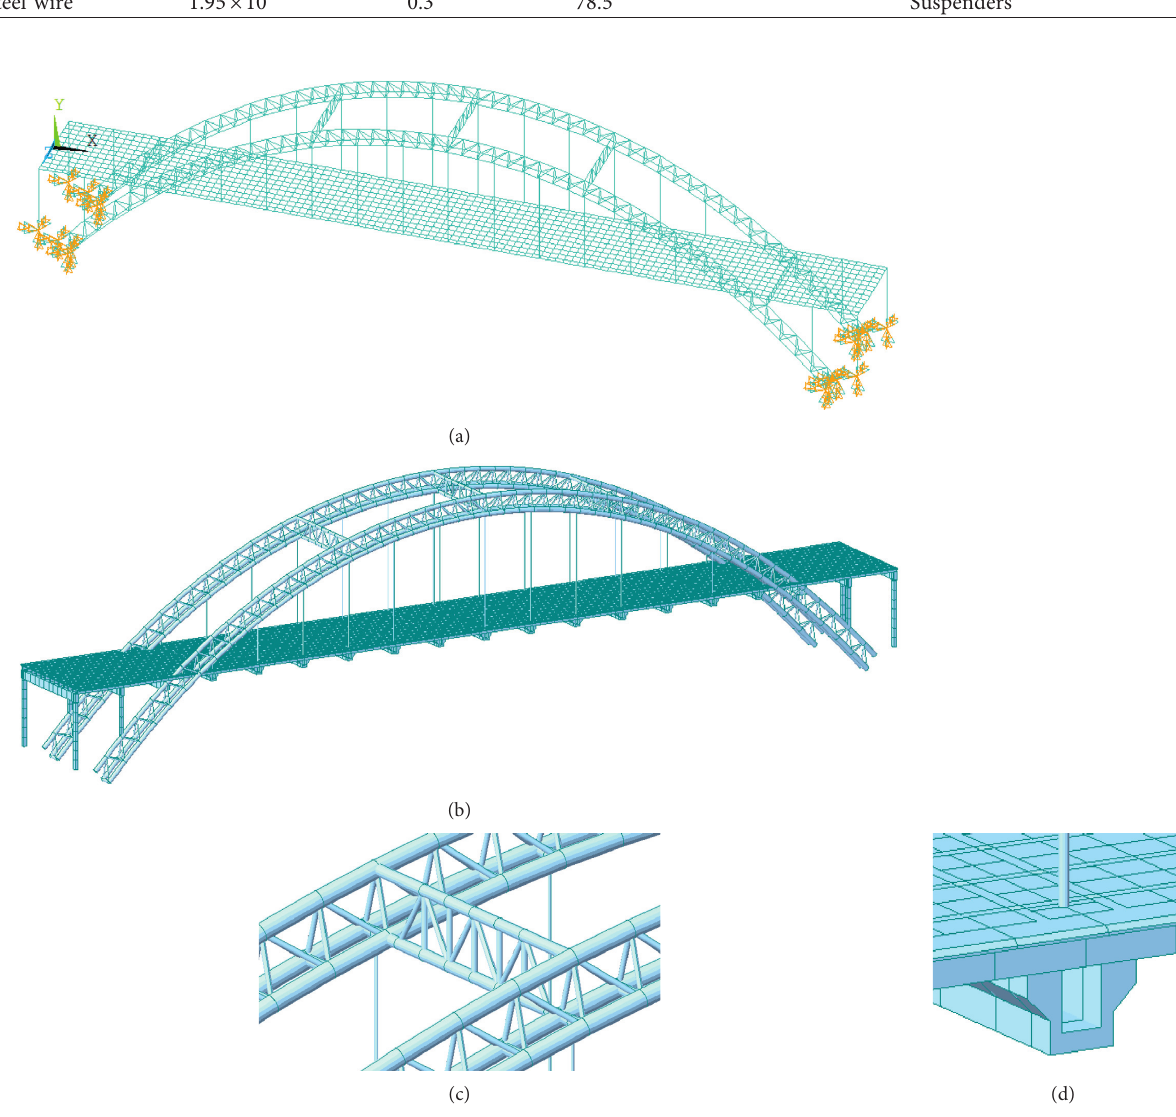
Figure 4: Finite element model: (a) spatial grillage model; (b) spatial grillage model with visual shapes; (c) wind bracing; (d) transverse